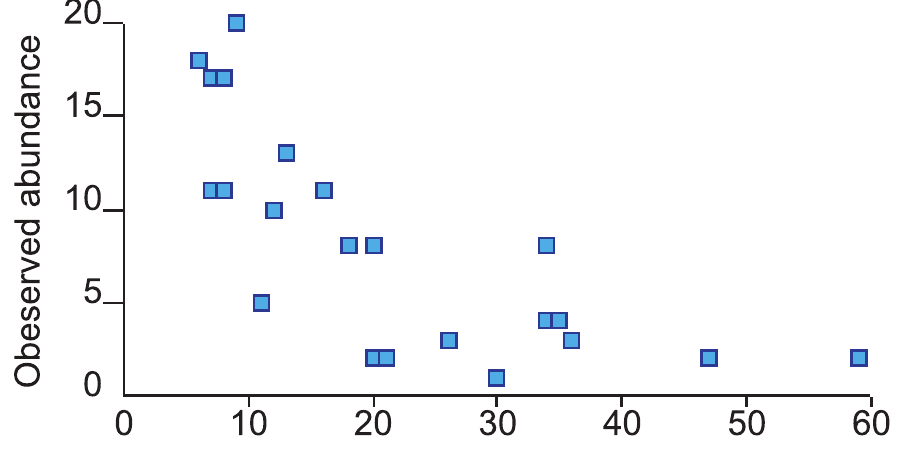
Fig 3. Relationship between the observed abundance (burrows/Km 2 ) of Gopherus flavomarginatus and the distance to the species´ ecological niche